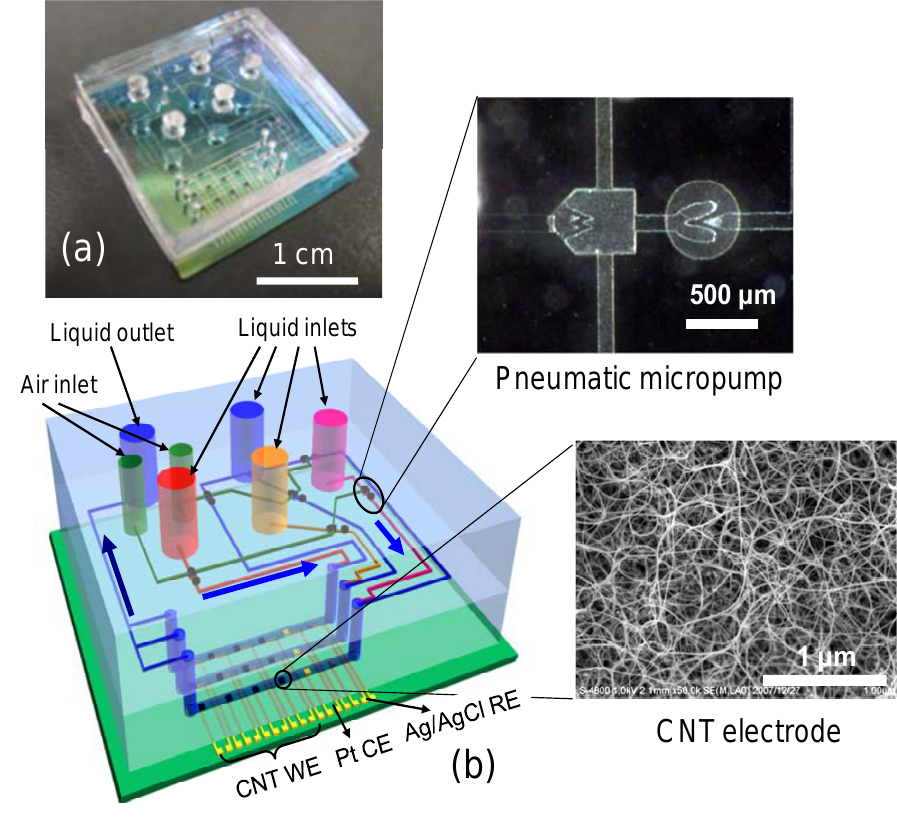
Figure 3. (a) Optical image and (b) schematic illustration of a microfluidic chip based on CNT electrodes. Inset: a SEM image of a CNT electrode and an optical image of a pneumatic